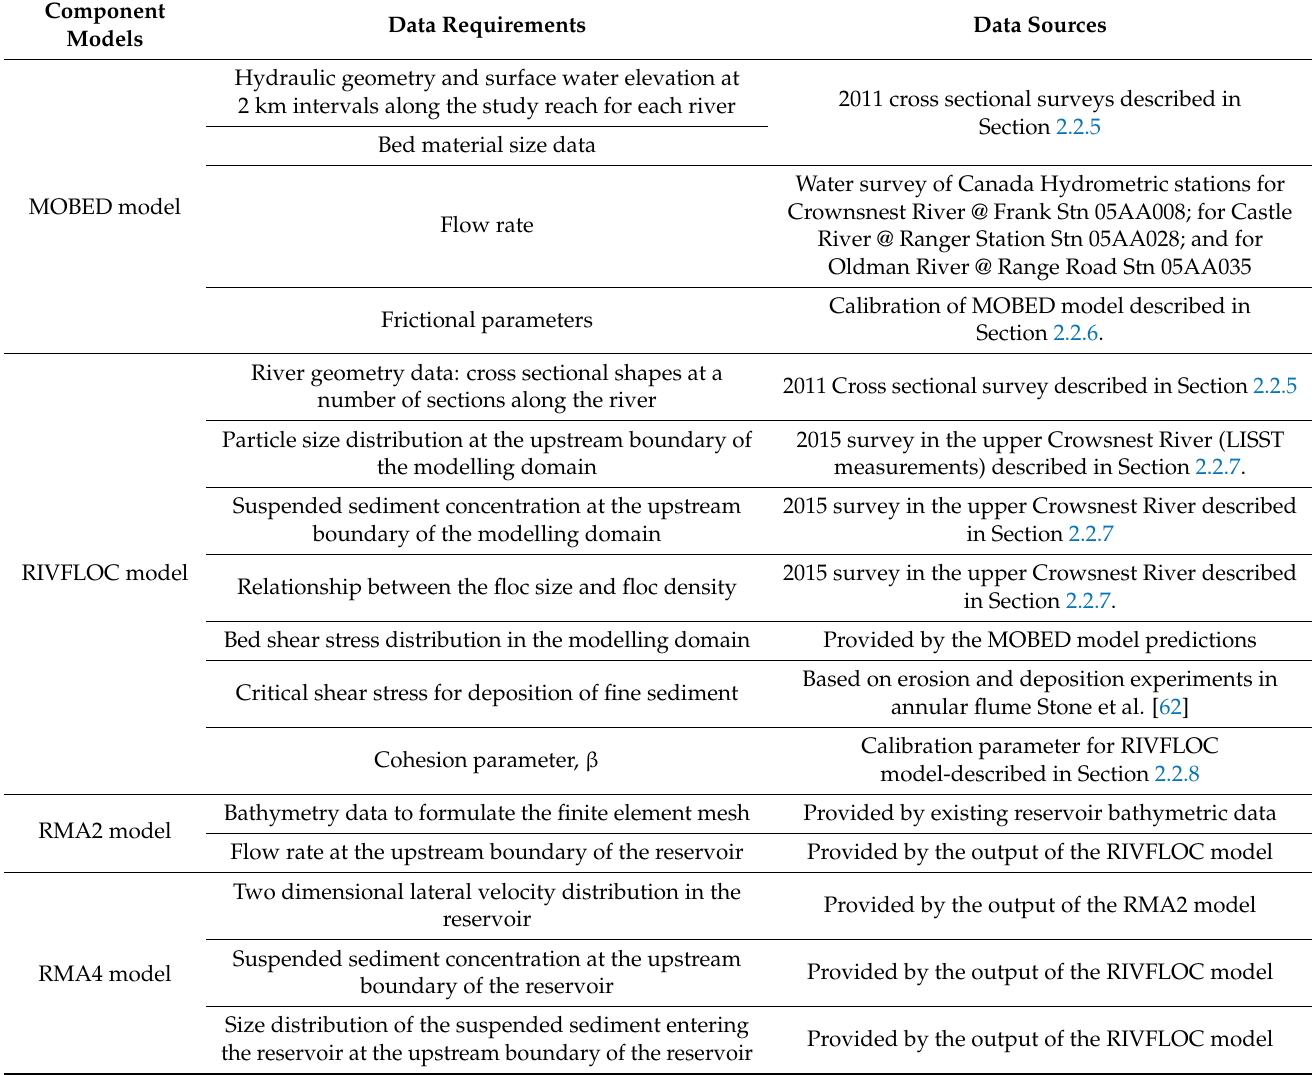
Table 1. Model input data requirements and corresponding